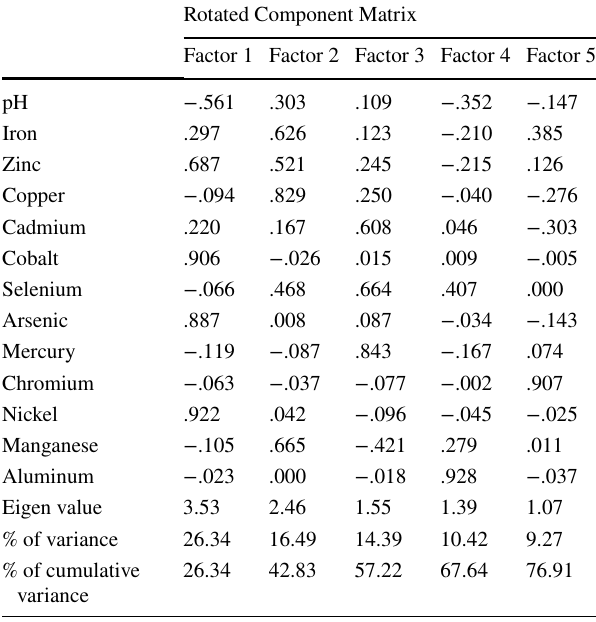
Table 4 Rotated varimax principal component analysis of the